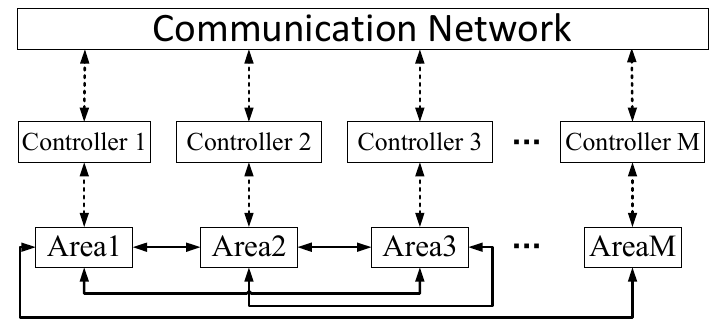
Figure 1. Multi-area interconnected power system.